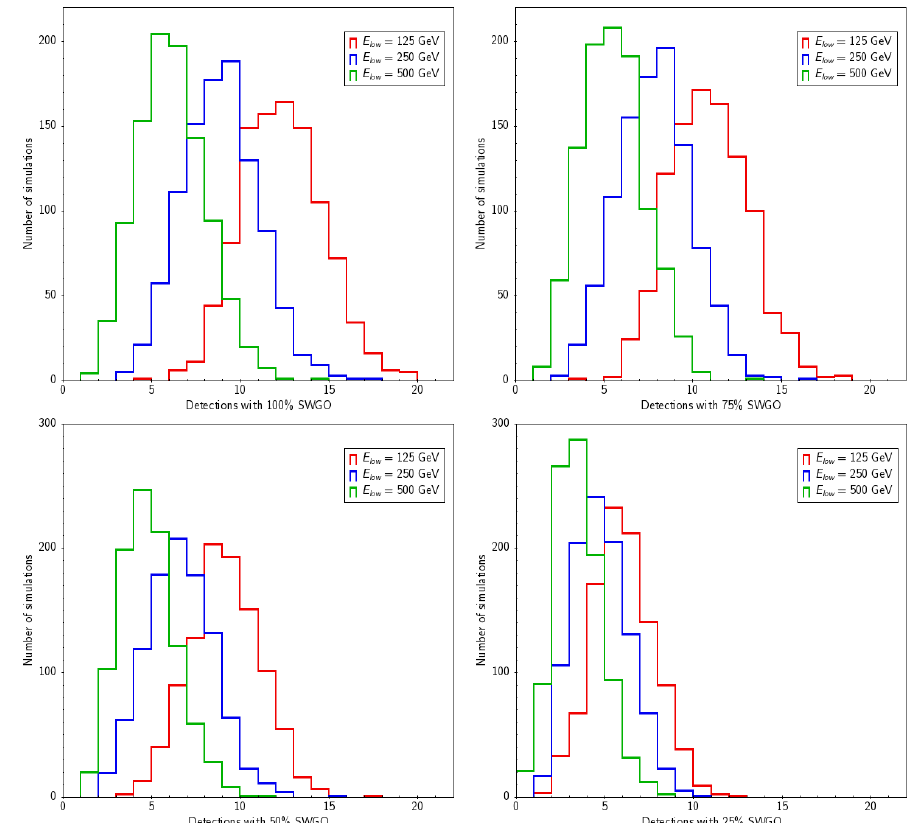
Figure 5. From upper left to lower right: histograms of the number of expected detections of GRBs extracted from 2FLGC and associated with 1000 random redshift values, computed for flux integrations above a low energy threshold of E low = 125GeV (red histograms), 250GeV (blue histograms) and 500GeV (green histograms), with an overall performance reaching up to 100%, 75%, 50% and 25% of the optimal SWGO sensitivity and zenith distance up to ϑ = 20 o . The optimal SWGO design is expected to be able to detect more than 10 GRBs in an observing period of 10 years in more than 750 simulations out of 1000. Reductions of performance or higher energy thresholds reflect in gradually lower expected detection